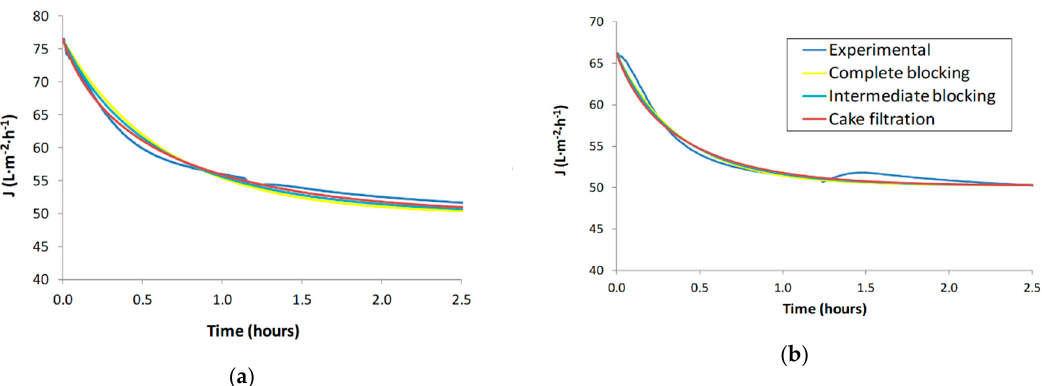
Figure 3. Fitting of Hermia’s model of secondary effluent wastewaters: ( a ) S1 (5 ‐ micron filtered), ( b ) S2 (5 ‐ micron filtered).